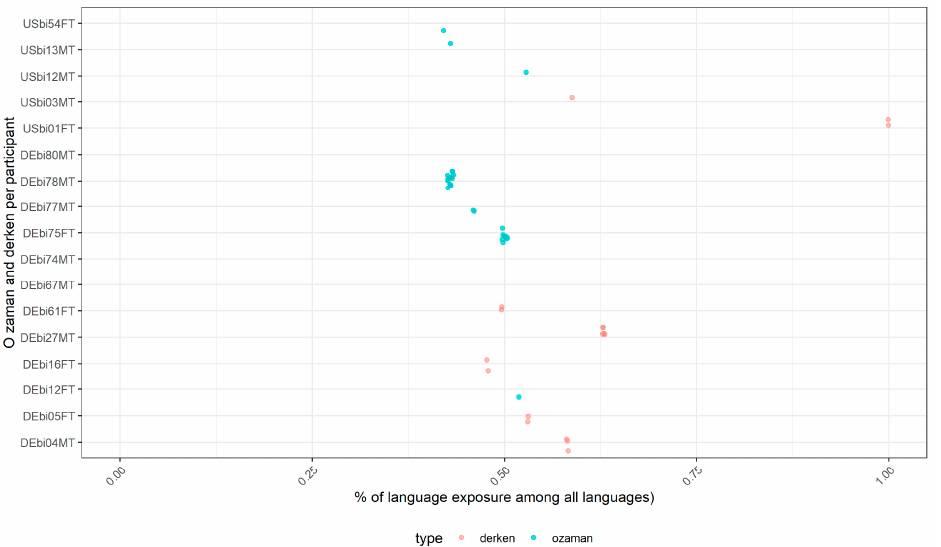
Figure A2. Jitter plot showing the total % of Turkish language exposure per participant regarding their uses of o zaman and